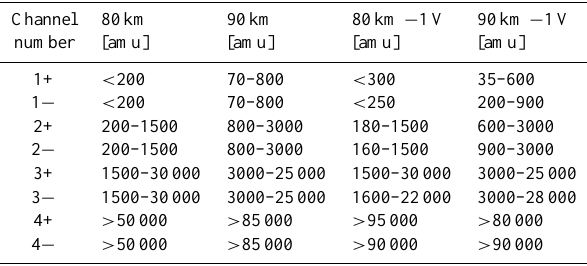
Table 1. Ranges of masses detected by each of the eight MASS channels calculated for atmospheric conditions at 80km and 90km. Columns 2 and 3 are with no assumed rocket potential. Columns 3 and 4 are with an assumed potential of − 1V (Knappmiller et al., 2008). The range listed is the range for which the collection effi- ciency for the channel exceeds half the maximum for that channel.